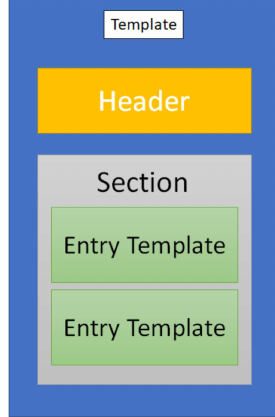
Figure 2. Clinical document architecture (CDA) message